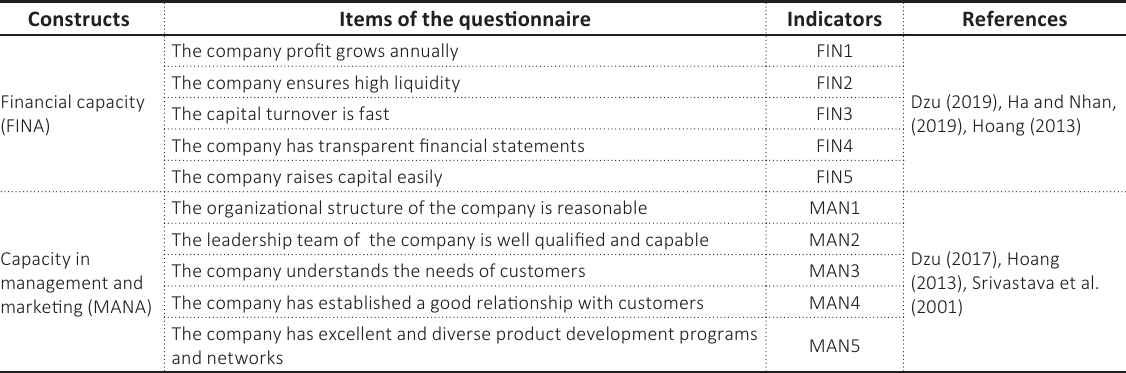
Table 1. Constructs, indicators, and questionnaire